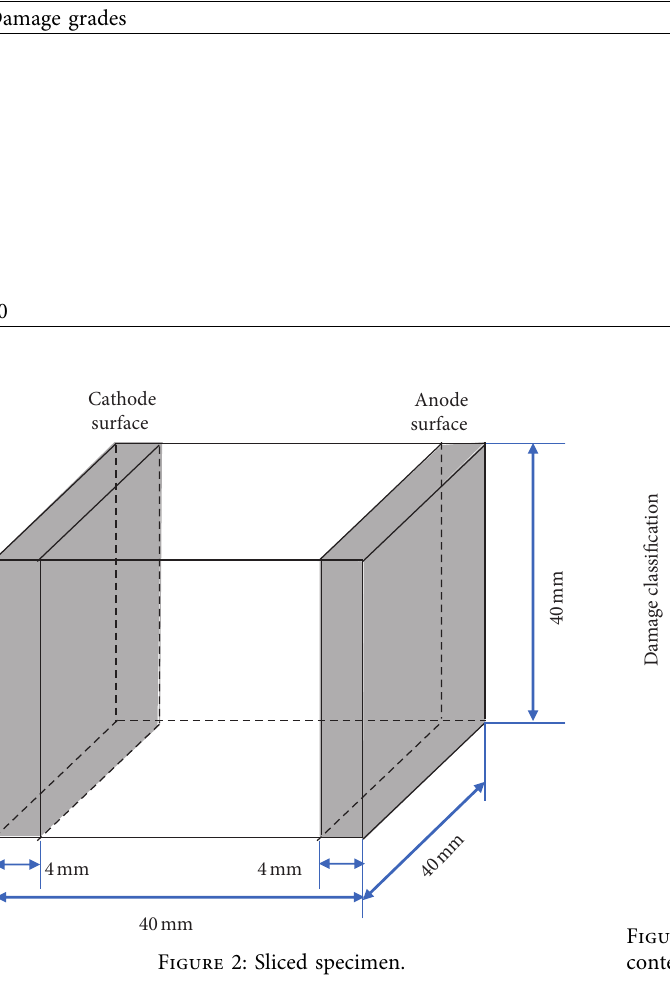
Figure 1: Mould and schematic diagram for electrification. Table 3: Corrosion damage grade of TSA [20].